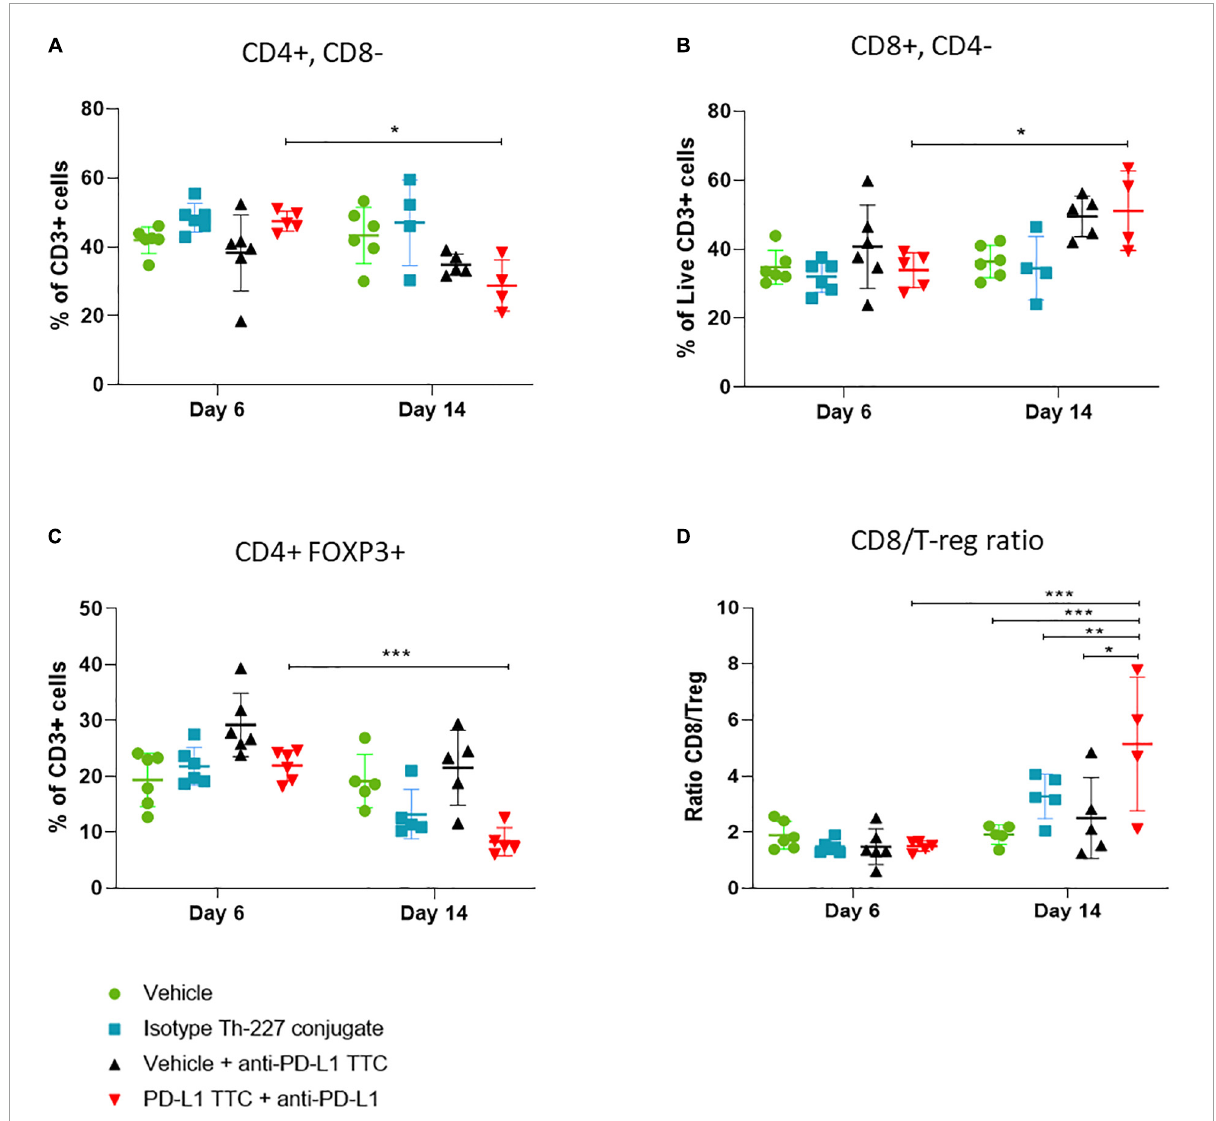
FIGURE6 Lymphocytes (%) that are CD3+ in tumors, in each treatment group, n = 5/group. (A) CD3+ cells (%) that are CD4+ CD8- in tumors, representing T-helper cells, n = 5/group. (B) CD3+ cells (%) that are CD8+ CD4-, representing cytotoxic T-cells, n = 5. (C) CD3+ cells (%) that are CD4+ FOXP3+ CD25+ in tumors, representing T-regulatory cells, n = 5/group. (D) Ratio of CD8+ cells to T regulator cells in tumor, n = 5. Student’s t -test * p < 0.05, ** p < 0.01, *** p <